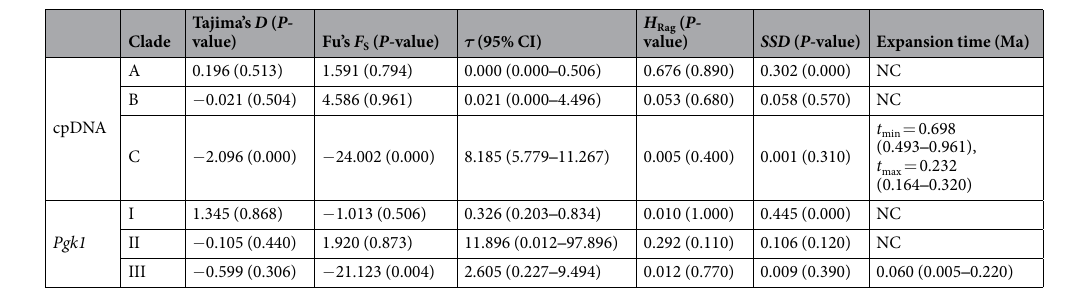
Table 4. Mismatch distribution and neutrality tests for populations of clades of Indigofera bungeana complex. NC, not calculated; SSD , sum of squared deviations; H Rag , Harpending’s raggedness index. t min : time